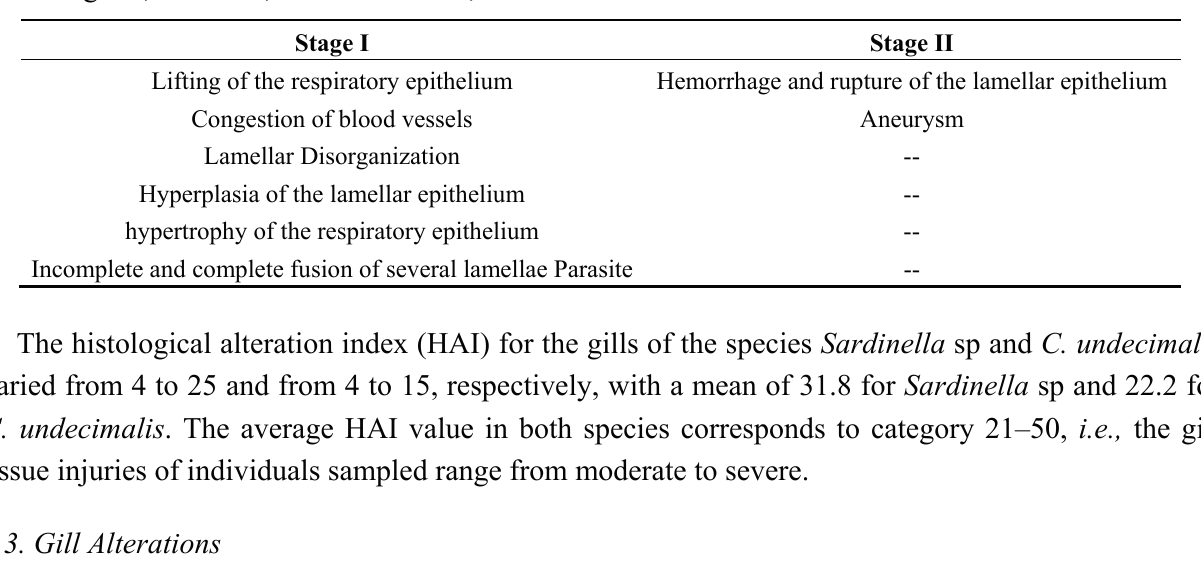
Table 2. Classification of histological alterations of the gills of fish collected in the Jansen Lagoon, São Luís, Maranhão State,